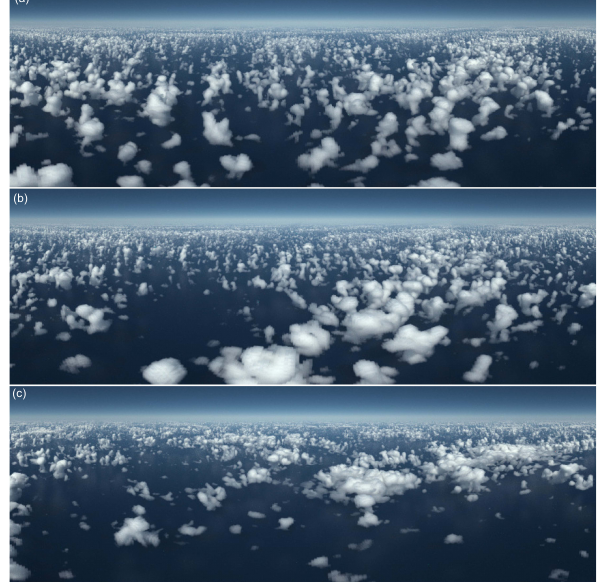
Figure 7. Visualization of the cumulus cloud field of the constant cooling (a) , 3-D Thermal AVG (b) and 3-D Thermal NCA (c) simu- lations. The snapshot of the cloud field is taken at 20h of the simula- tion. The visualization was performed with the 3-D radiative trans- fer model MYSTIC (Mayer,